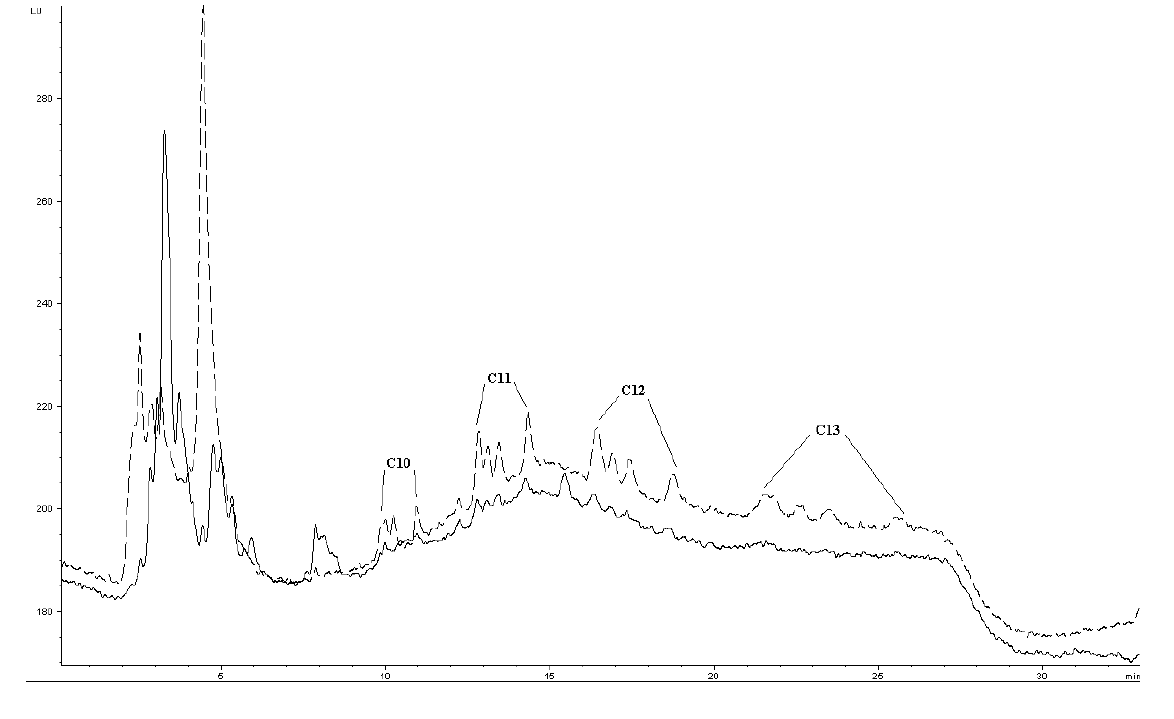
Figure 7. The lower chromatogram is obtained from an extract from sewage treatment plant (STP) effluent spiked with 25 µg L − 1 and the upper chromatogram (dashed line) represents a 1 mg L − 1 standard. Given concentrations refer to nominal concentrations and not to the concentration of each isomer peak. Conditions as Figure